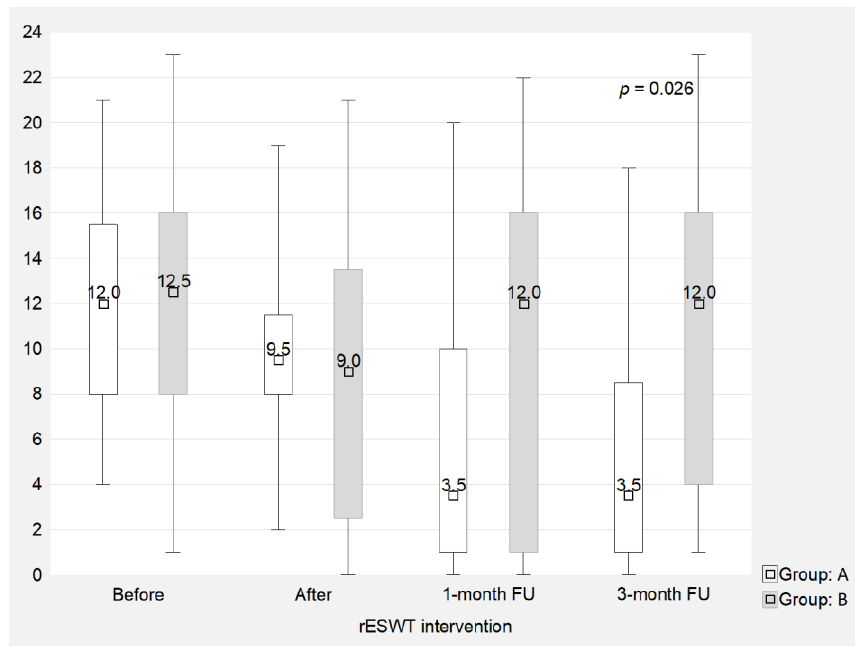
7 of 12 Figure 4. Comparison of pain outcomes (LPS) between two groups (points). LPS: Laitinen Pain Scale.